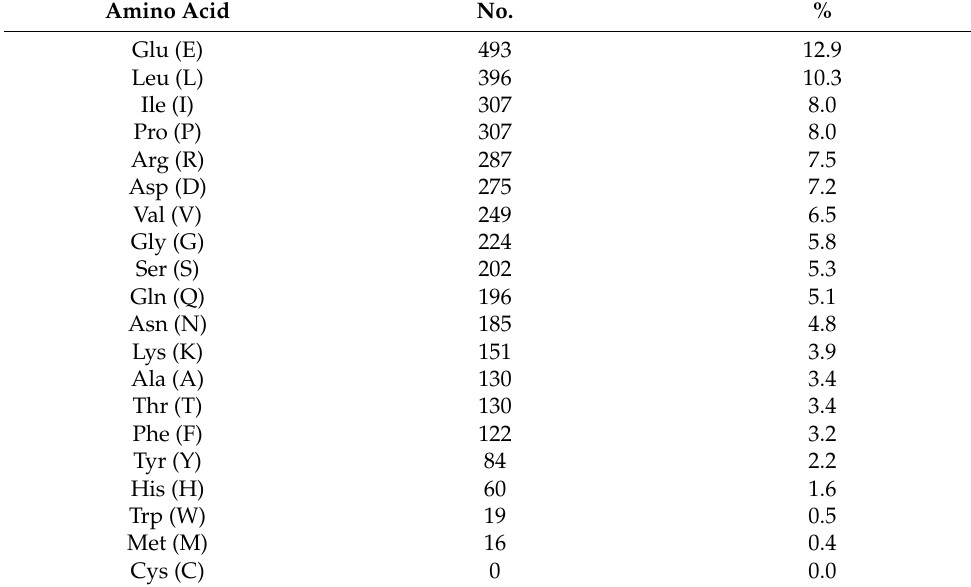
Table 1. Amino acid composition of the identified peptides in the LPH.